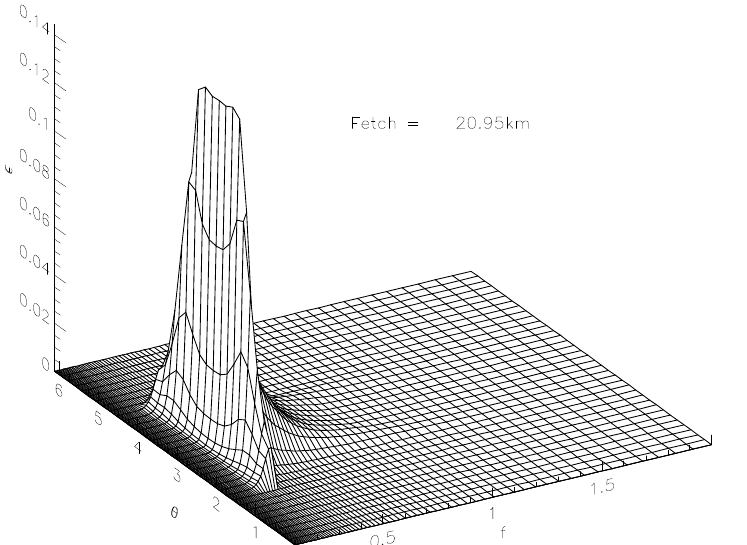
Figure 6. Spectral wave energy density ε as the function of the frequency ω and angle θ for ST6 case. Figure 7 shows the angle-averaged wave energy spectrum corresponding to the previ- ous figure as the function of the logarithm of